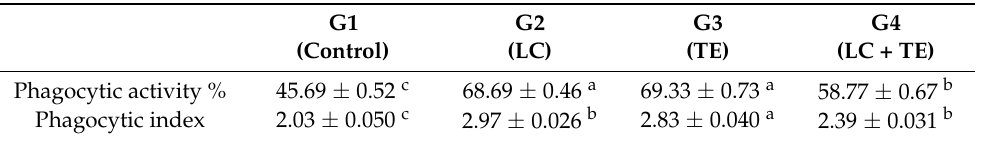
Table 2. Effect L-carnitine and/or calf thymus extract supplementation on phagocytic activity and phagocytic index in Japanese quail (mean ± SE), n = 10.